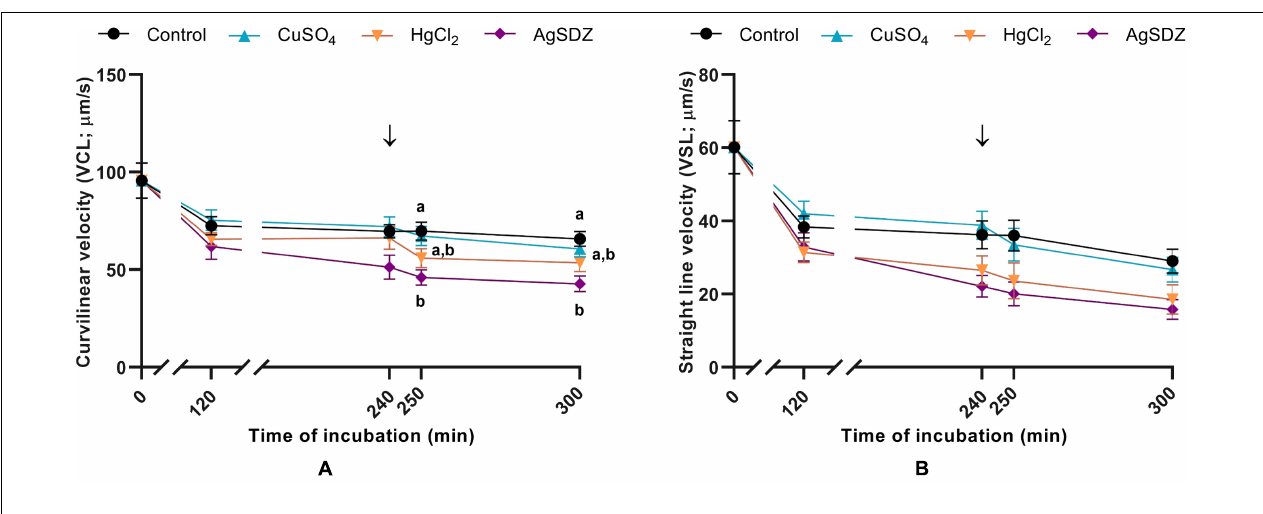
FIGURE 2 | Sperm kinetics parameters. (A) Curvilinear velocity (VCL, µ m/s) and (B) straight-line velocity (VSL, µ m/s) in samples exposed to the presence or absence of different AQP inhibitors in the capacitation medium: cooper sulfate (CuSO 4 ), mercury chloride (HgCl 2 ) and silver sulfadiazine (AgSDZ). Data were collected after 0, 120 and 240 min of incubation in capacitation medium. At this point, progesterone was added to capacitation medium (arrow) and data were collected after further 10 min and 60 min of incubation. Data are shown as mean ± SEM, and different letters (a,b) indicate significant differences ( P < 0.05) between different treatments within a given time